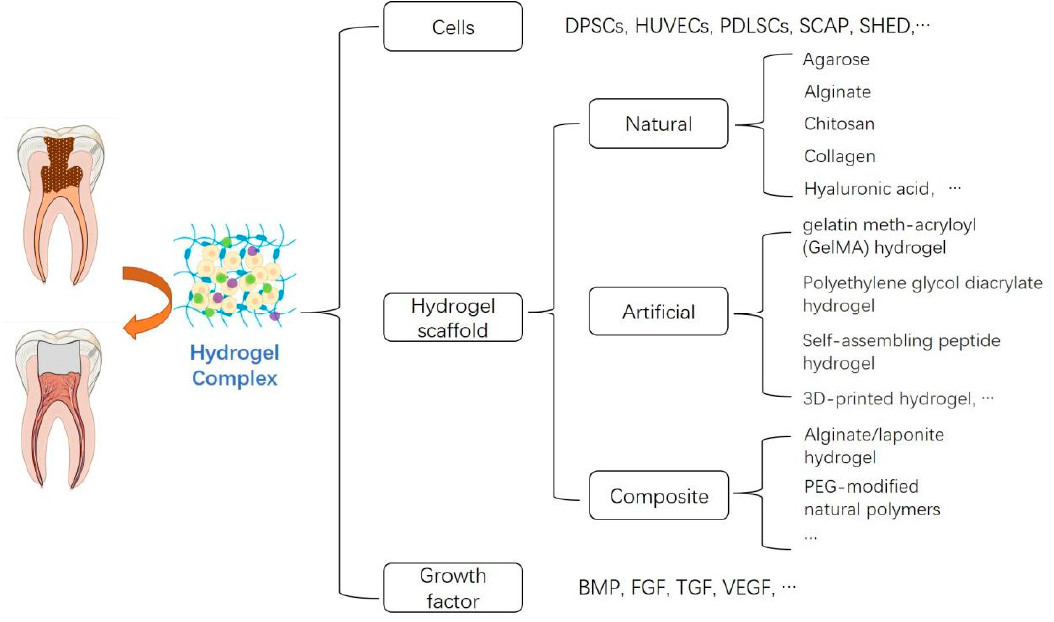
Figure 4. The classification of hydrogel complex in pulp tissue regeneration.